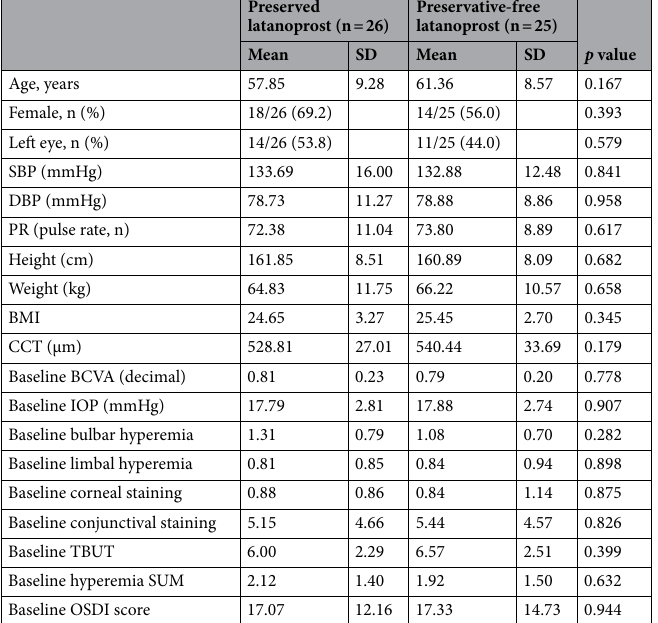
Table 1. Demographics and baseline outcome measures of the preserved and preservative-free latanoprost groups. (ITT set). *ITT, intention-to-treat; SBP, systolic blood pressure; DBP, diastolic blood pressure; PR, pulse rate; BMI, body mass index; CCT, central corneal thickness; BCVA, best-corrected visual acuity; IOP, intraocular pressure; conjunctival staining, sum of all six areas; TBUT, tear break-up time; hyperemia SUM, bulbar + limbal hyperemia score; OSDI, Ocular Surface Disease Index.